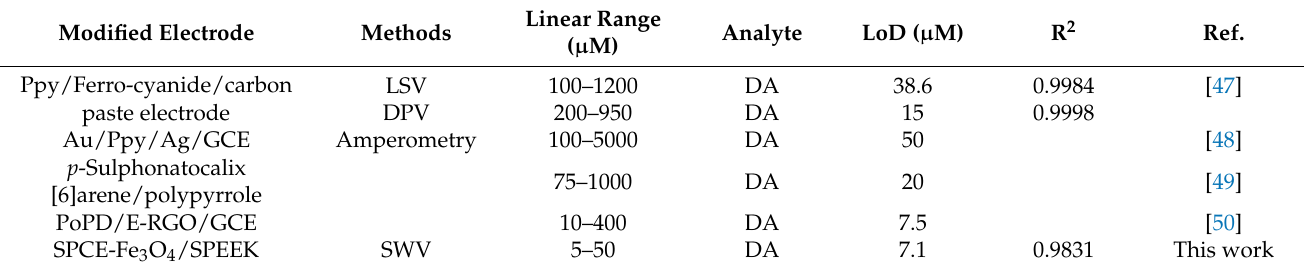
Figure 12. ( a ) Square wave voltammograms recorded at SPCE-Fe 3 O 4 /SPEEK electrode over dopamine concentrations range from 5 to 50 μ M; ( b ) linear graph of reduction peak currents versus DA concentrations prepared in 0.1 M of PBS (pH 7.4). Table 3. Comparison of the designed sensor with previously studied sensors for DA